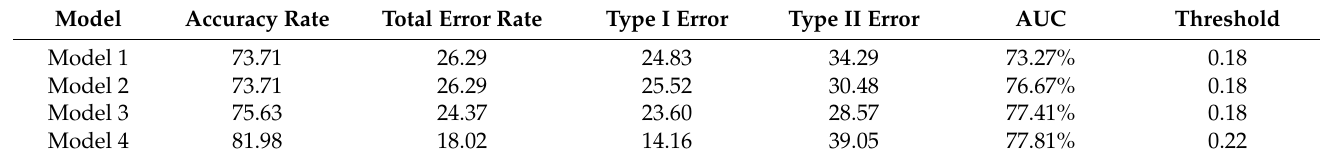
Table 9. Models’ predictive